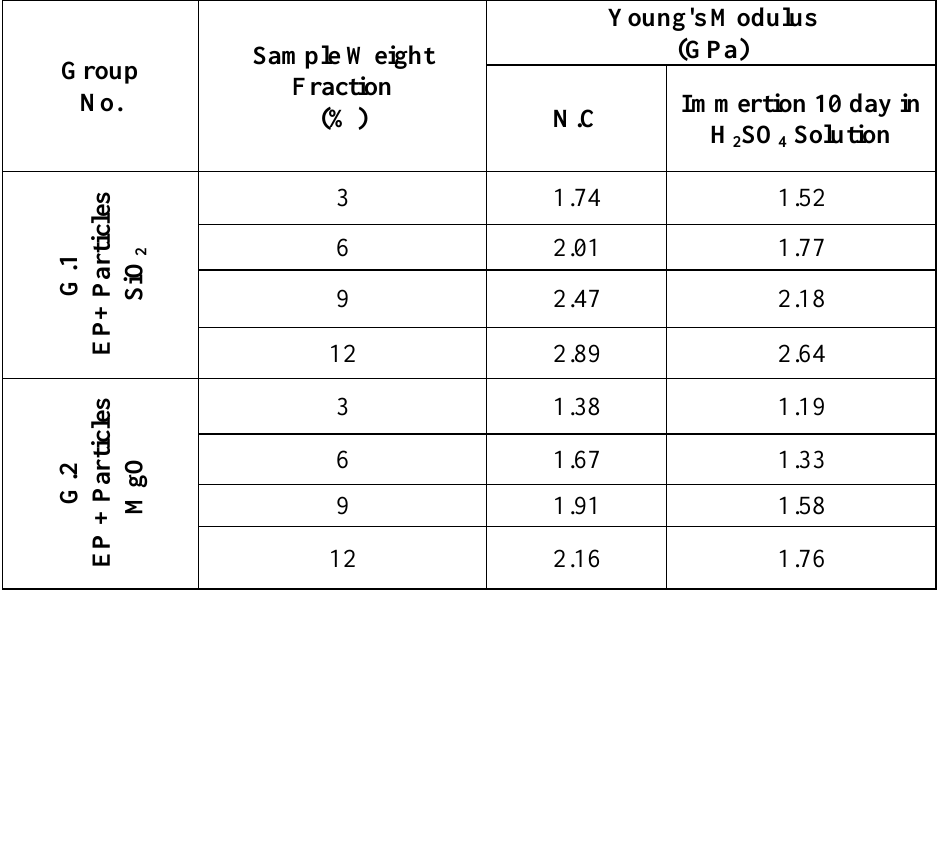
SO and for 10 2 4